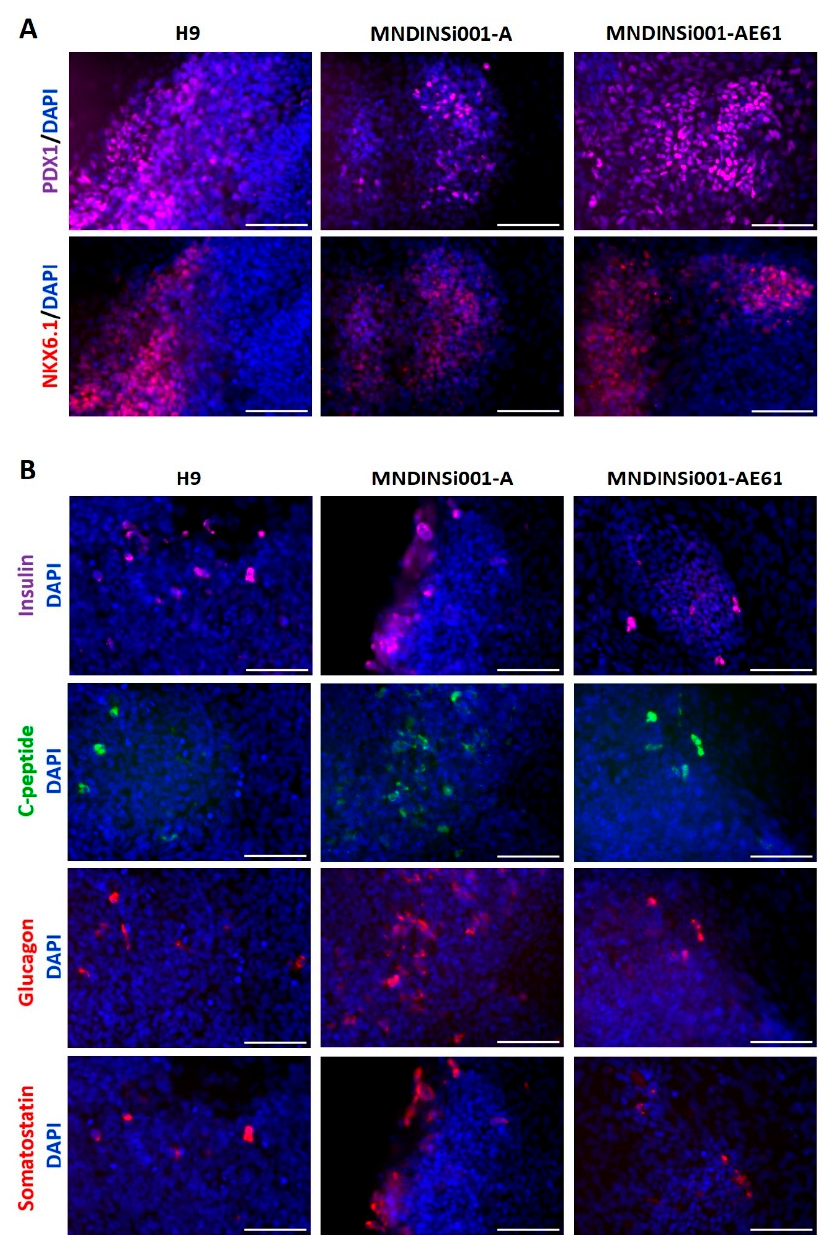
Figure 2. The potential of isogenic iPSC lines to differentiate into pancreatic lineage. ( A ) Immunocytochemistry for pancreatic progenitor markers PDX1 and NKX6.1 in H9 (gold-standard), MNDINSi001-A (mutant), and MNDINSi001-AE61 (CRISPR/Cas9-corrected) cell lines at day 14 of differentiation. ( B ) Immunocytochemistry for insulin and C-peptide (beta-cell hormones), glucagon (alpha cell hormone), and somatostatin (delta-cell hormone) in H9 (gold-standard), MNDINSi001-A (mutant), and MNDINSi001-AE61 (corrected) cell lines at day 14 of differentiation. Scale bars, 100 µm.